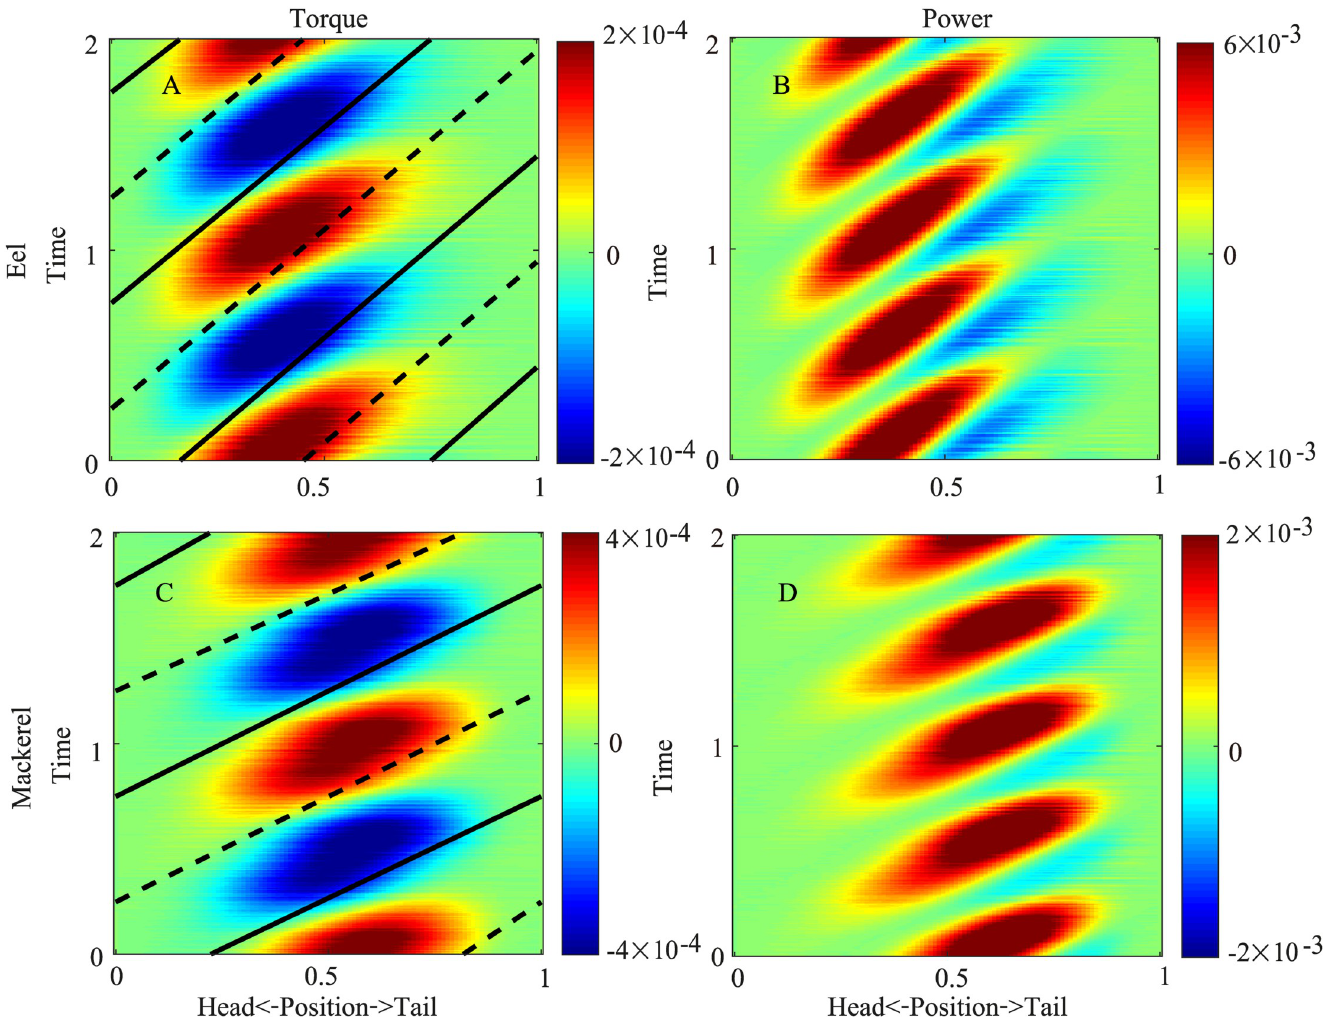
Fig 8. Torque (A) and power (B) distributions when the viscosity of the body is considered for the eel and torque (C) and power (D) distributions for the mackerel. The solid and dashed lines indicate the maximum and minimum curvatures, respectively.